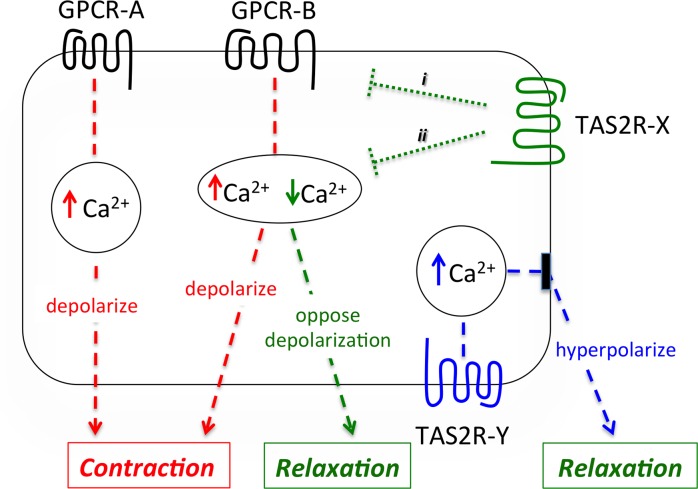
Model of TAS2R signaling to relaxation of HASM.Stimulation of GPCR-A results in an increase in [Ca2+]i, depolarization, and contraction (red). GPCR-A is not influenced by TAS2R interaction, thus [Ca2+]i mobilization and ultimately contraction is not affected. Activation of certain GPCRs (GPCR-B) also promote contraction by increasing [Ca2+]i, but are influenced (green dotted lines) by TAS2R agonists (acting at TAS2R-X). This results in a decrease in [Ca2+]i, which opposes depolarization and relaxes HASM (green). This GPCR-B/TAS2R-X interaction could be in proximal (i) components or other downstream components (ii). TAS2R-Y does not specifically interact with a procontractile GPCR, but relaxes HASM by a calcium-dependent transducer, such as BKCa, that hyperpolarizes the membrane (blue).